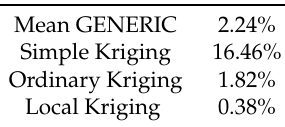
Table 1. 2-norm errors in the obtention of the GENERIC